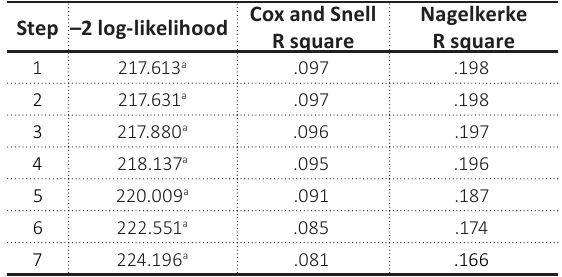
Table 8. Summary of the